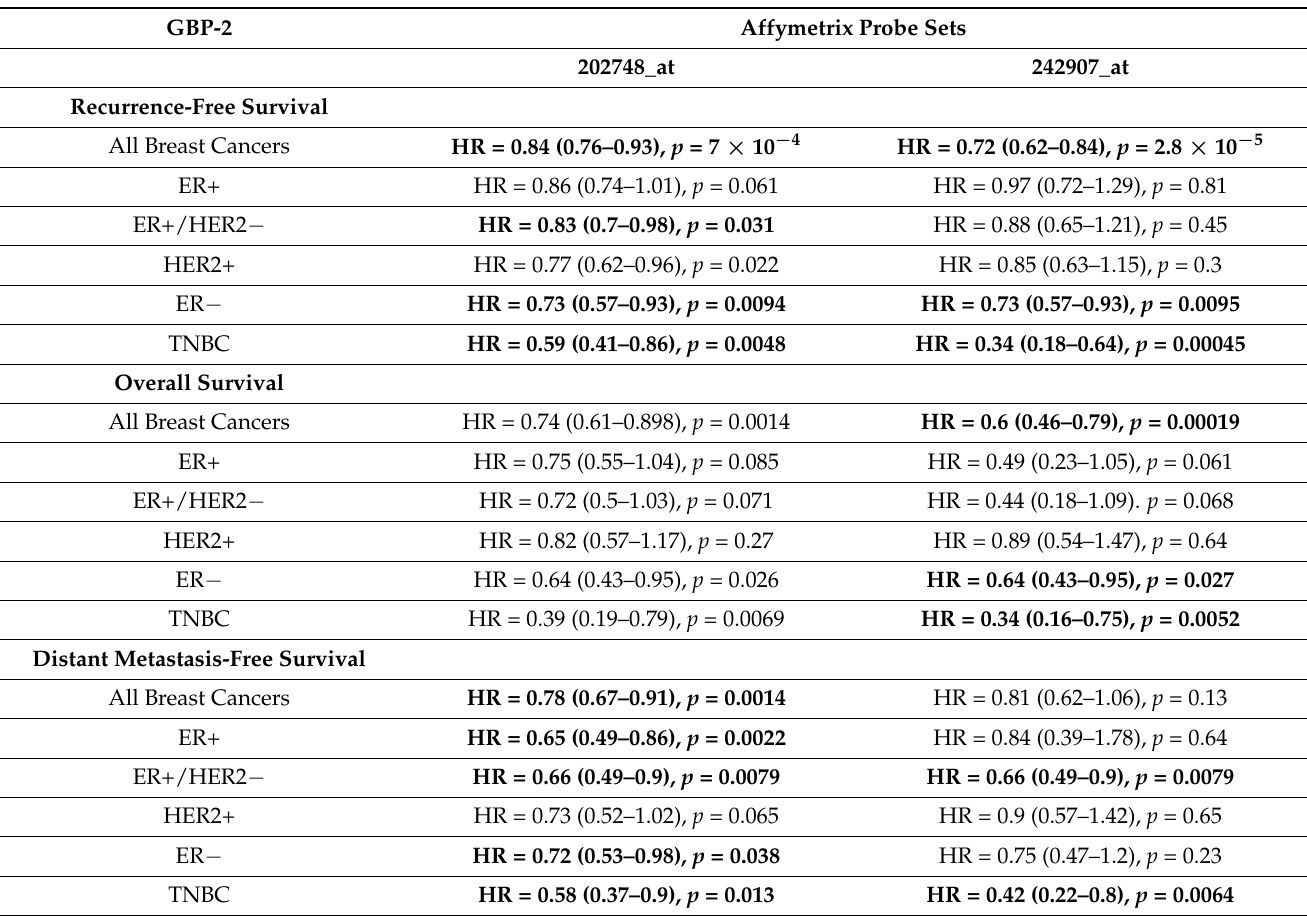
Table 6. Data from both GBP-2 probe sets of the HG-U133A Affymetrix microarray were analyzed for Recurrence-Free Survival (RFS), Overall Survival (OS), and Distant Metastasis-Free Survival (DMSF) using KmPlotter. All breast cancers included breast cancers of all histologies, hormone status, and grade. ER+ represents only those breast cancers positive for estrogen receptor but with any other hormone status. ER+/HER2 − contains the data from all ER+ breast tumors than were also HER2 − . There could be positive or negative for progesterone (PR). HER2+ tumors included those that were positive for HER2+ and had any other hormone receptor status. The data are presented as Hazard Ratio (HR) immediately followed by the HR. The range of numbers within the paratheses is the 95% confidence interval. p represents the LogRank p . Bold values are those that indicate that higher expression of GBP-2 significantly improves that